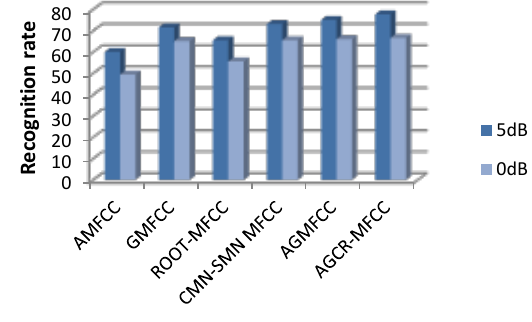
Figure 10. This figure shows that the results of experiments in the two noisy condition and as it is shown AGCR-MFCC has better recognition rate at noisy condition in comparative with other extracting MFCCs methods.